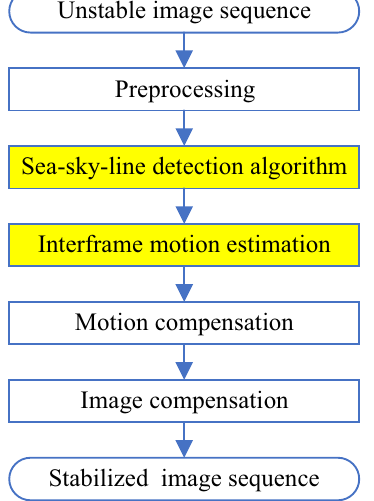
Figure 6. Flowchart of the electronic